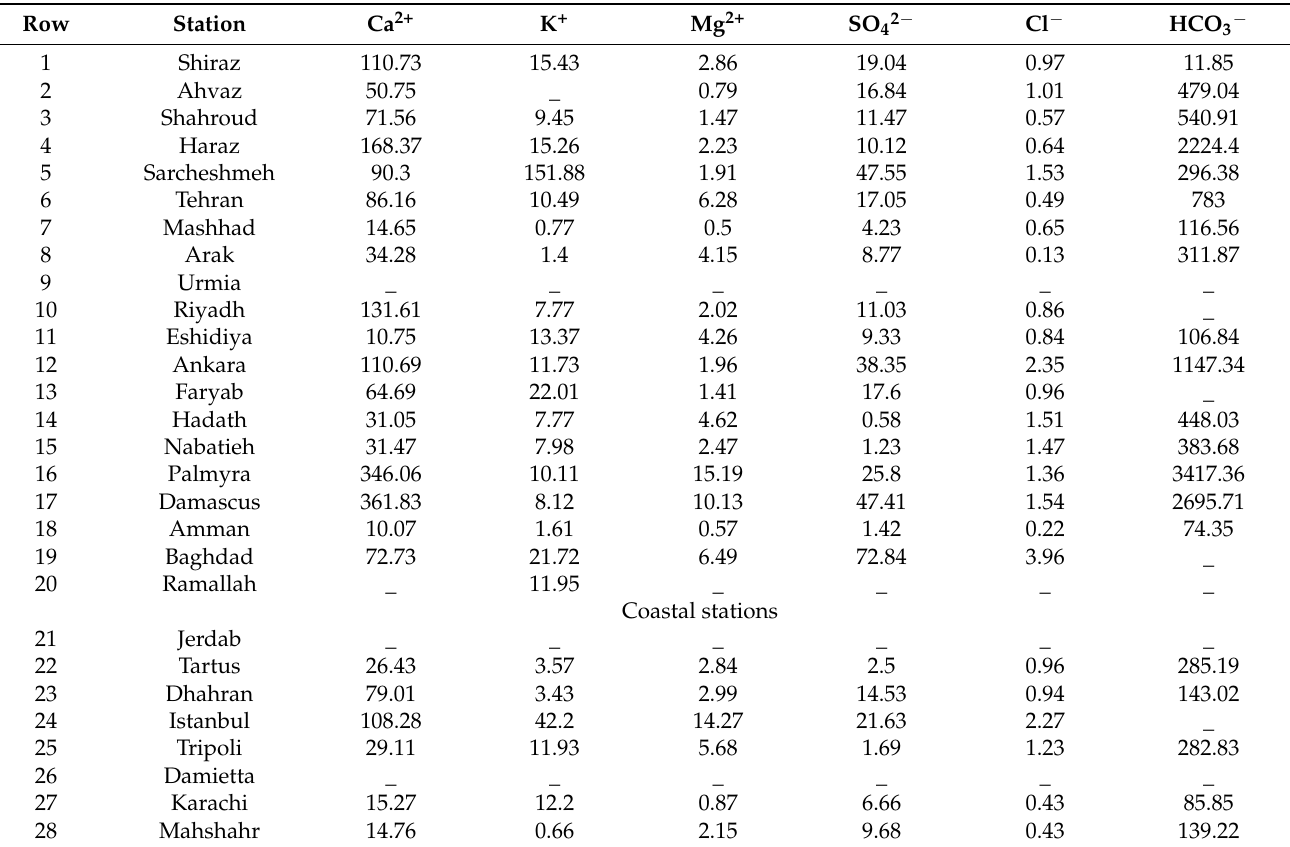
Table 2. The enrichment factor (EF) of the major ions in the Middle East